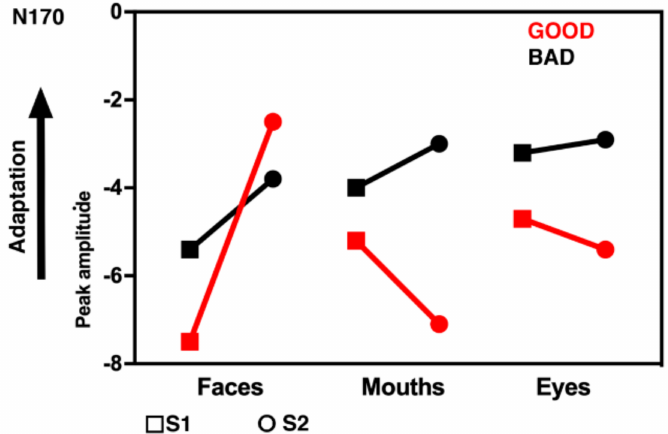
Figure 3. The adaptation effect of the N170 for bad and good recognizers: S1 is confronted with S2 for faces, mouths and